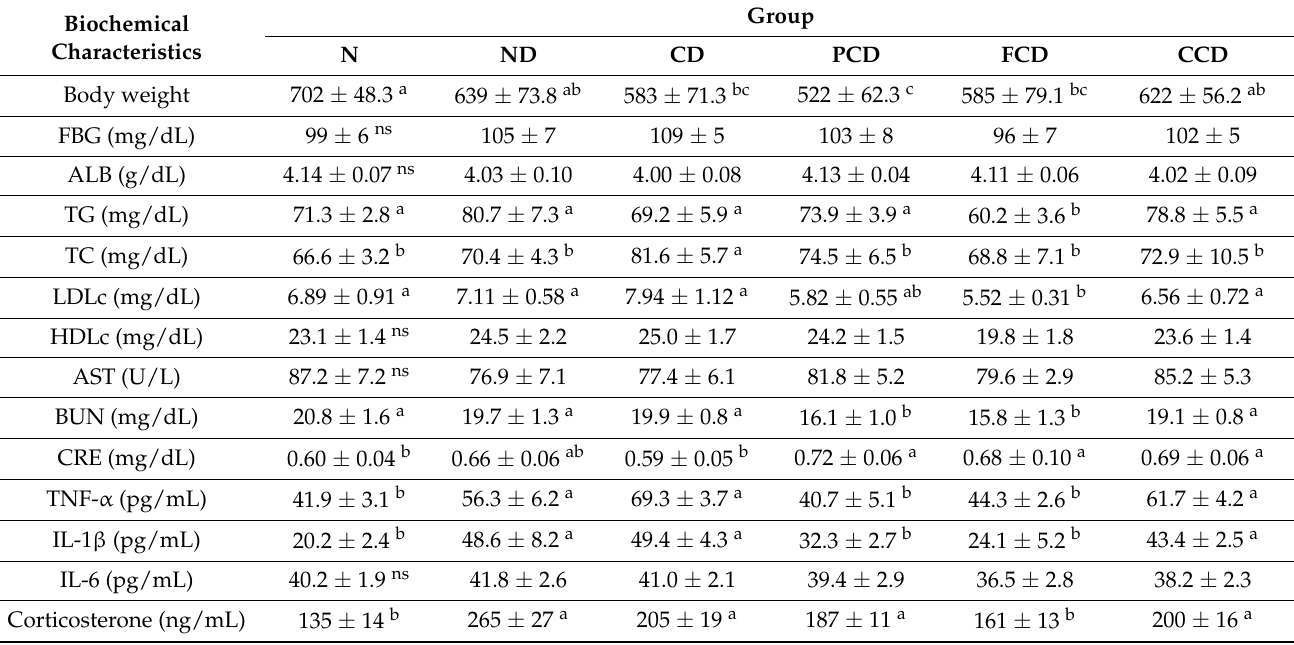
Table 2. Effects of fish oil on biochemical parameters in ageing